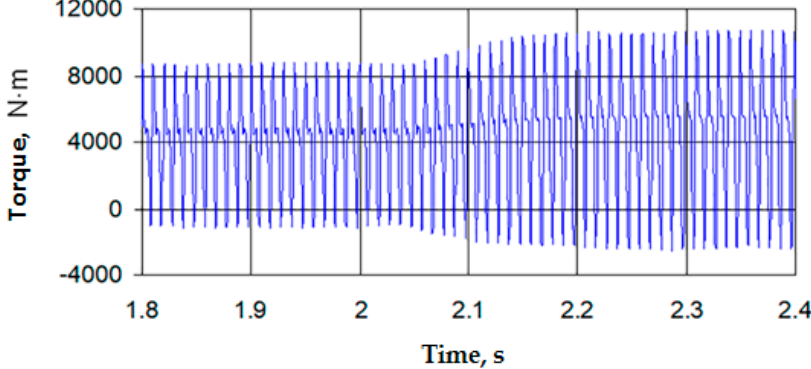
Figure 8. Dynamics of changes in torque on the crankshaft of a diesel engine with fuel and water injection into the intake manifold. (Source: Authors).